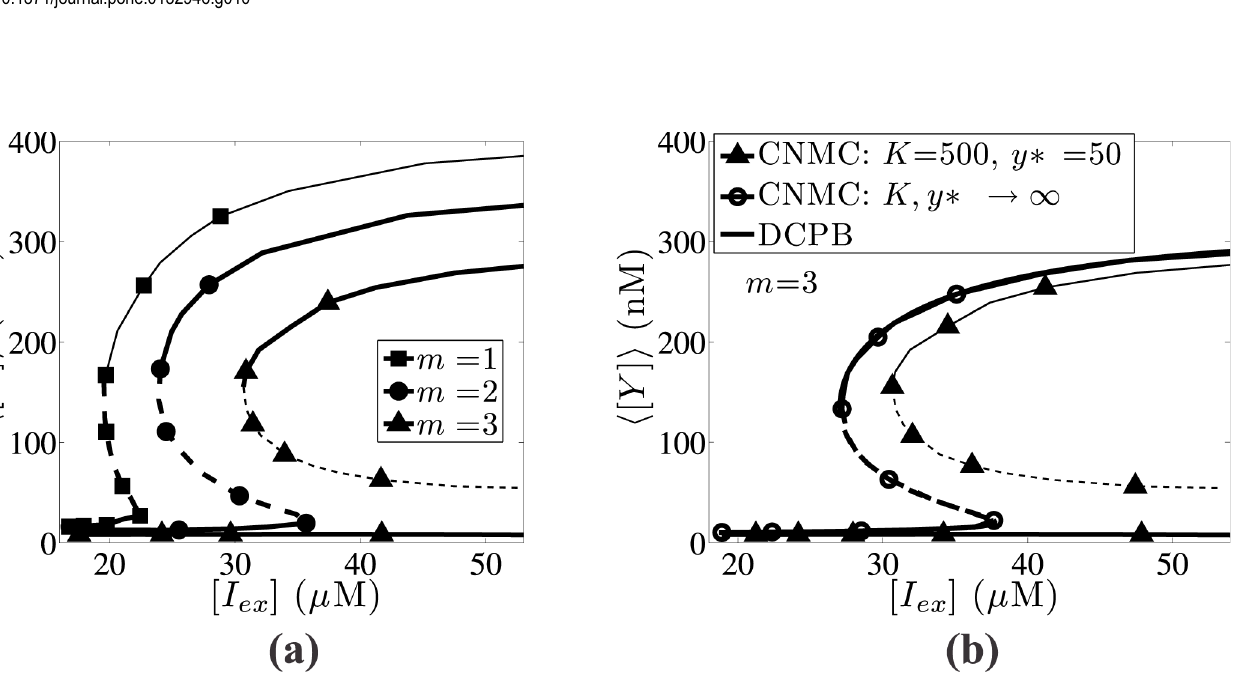
Fig 11. Effect of the sharpness division parameter. Effect of the sharpness division parameter, m , on the average expression of lacY gene steady state. (a) CNMC simulations of 10,000 cells with K = 500 and y * = 50. Lines with full squares correspond to m = 1, lines with full circles to m = 2 and lines with full triangles to the largest division rate, m = 3. (b) Comparison between the CNMC model with m = 3 ( lines with full triangles ) with the DCPB model ( black lines (solid and dashed) ) and the CNMC model neglecting intrinsic noise effects ( lines with open circles ). Parameter set values: f = 0.5, π = 0.03 and κ = 0.05.